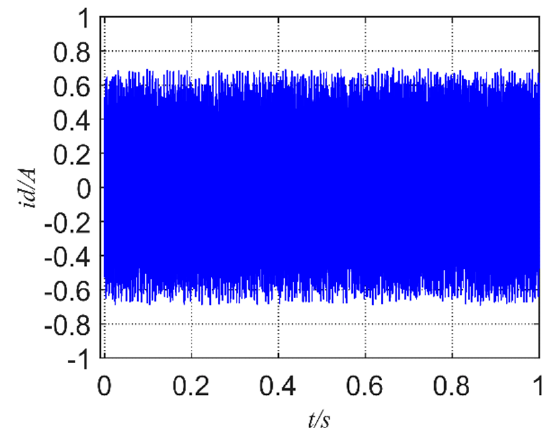
Figure 5. d - axis current of FCS-MPCC. Figure 5. d -axis current of